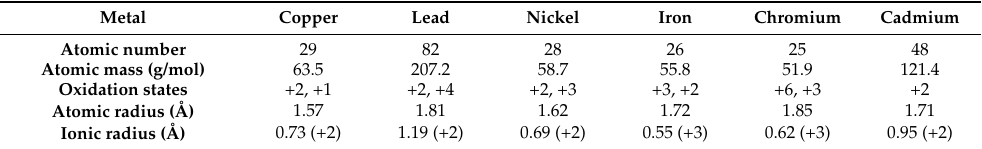
Table 1. Characteristics of M X+